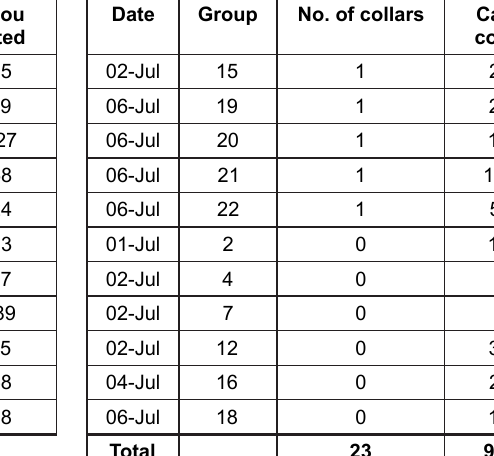
Table 2. Rivest model estimates and Lincoln-Petersen (LP) estimates for Bluenose-East herd 2000 survey.